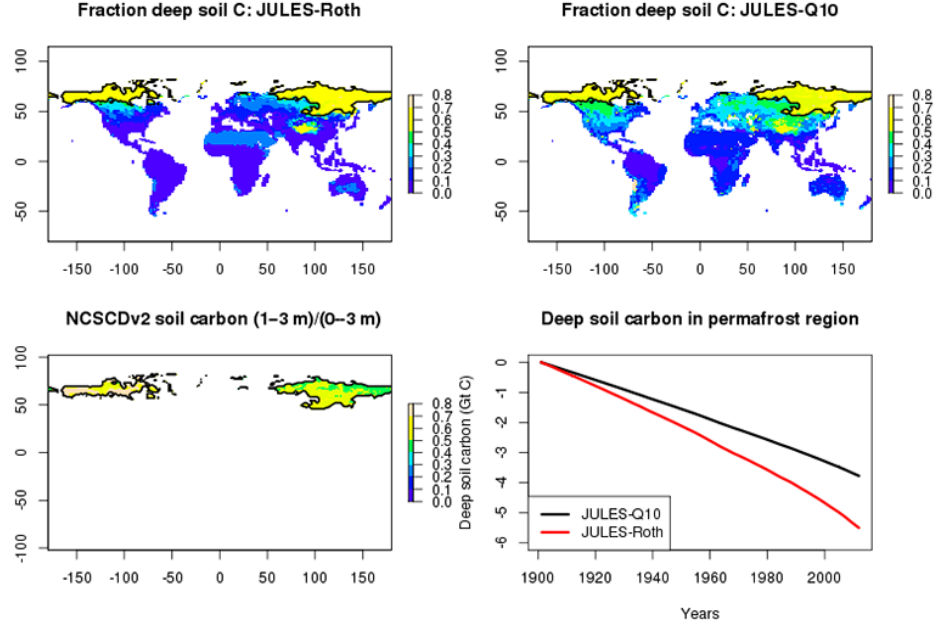
Figure 11. The spatial plots show the deep soil carbon (defined as soil carbon below 1m in 1901) as a fraction of the total soil carbon for each grid cell. The time series shows the change in labelled deep soil carbon for the permafrost region in Pg C. Table 2. Labelled deep soil carbon and total soil carbon in the permafrost region before and after adding the NCSCDv2 observed deep soil carbon for depths below 1m. Any differences between NCSCDv2 and the added labelled deep soil carbon are caused by differences between interpolation